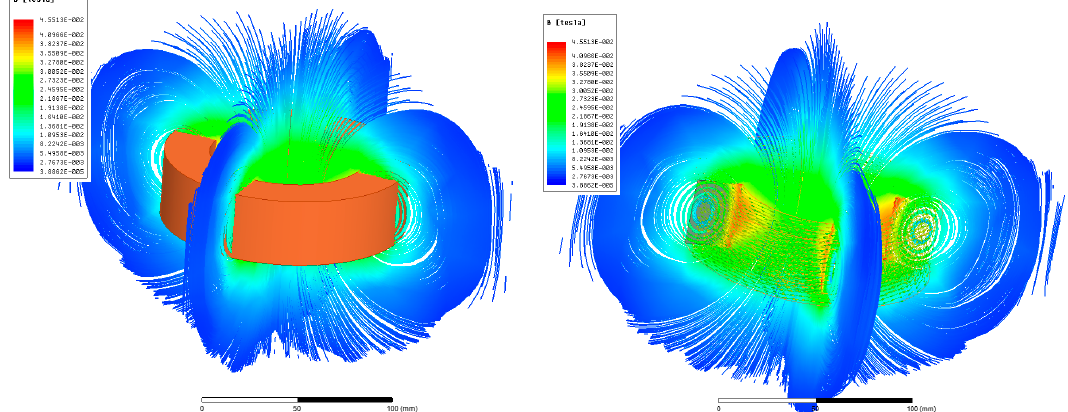
Figure 4. Finite element analyses (FEA) made under selected designs: magnetic flux density ( left ); magnetic flux density including current density in the winding ( right ).